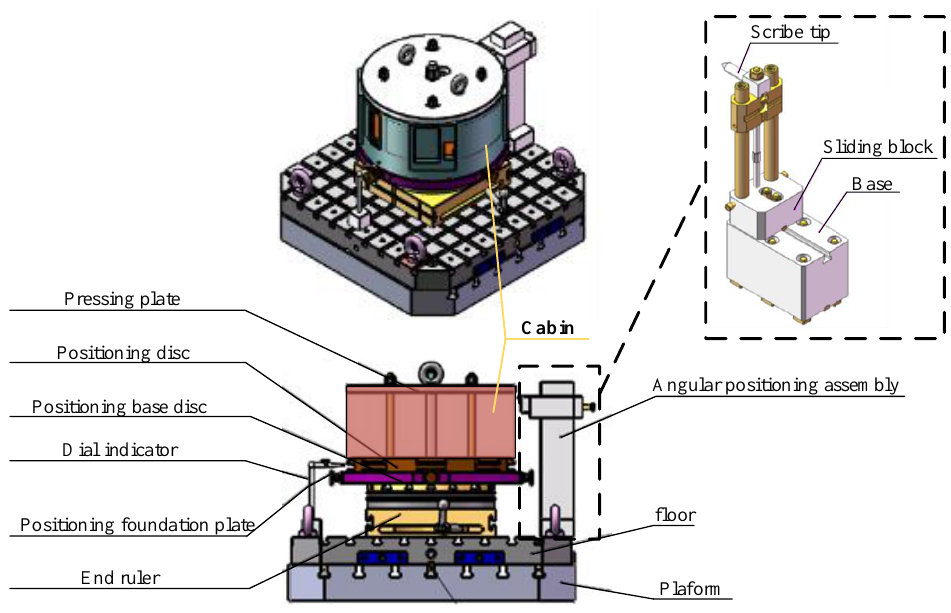
Figure 9. Rapid alignment device on off-machine.